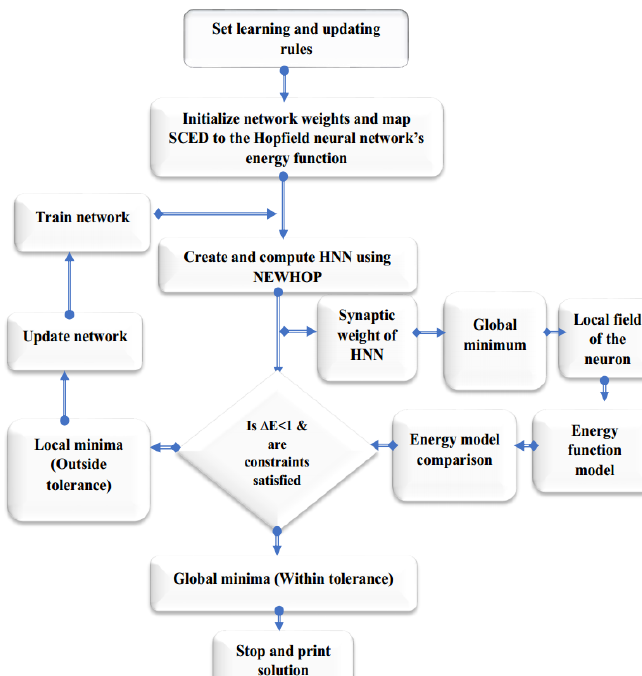
Figure 1. Flow chart for